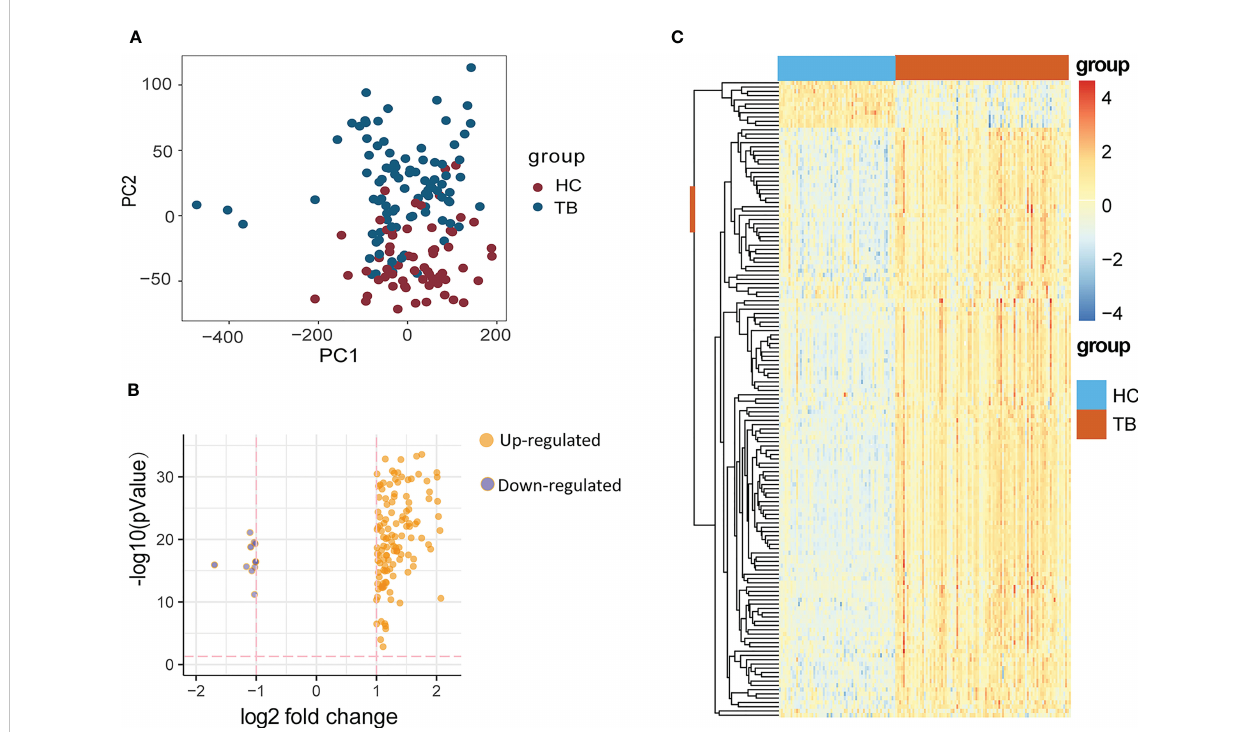
FIGURE 1 (A) PCA diagram showing the distribution of gene expression in HC and TB samples. (B, C) DEGs identi fi ed between HCs and TB patients were compared with a volcano plot (B) and a heat map (C) . DEGs, differentially expressed genes; HC, Healthy control; TB,